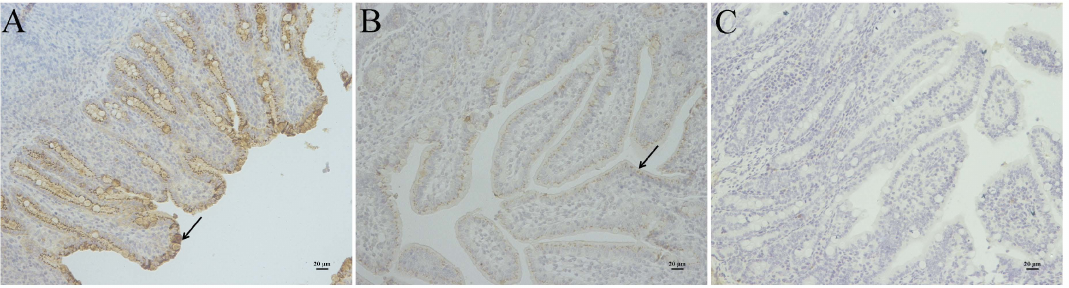
Figure 3. The immunohistochemical (IHC) assay of pigs infected with YN15 ( A ) and YN144 ( B ) as well as control group ( C ) are indicated. Arrows indicate positive signal of IHC assay in the intestinal tissue. Original magnification ˆ